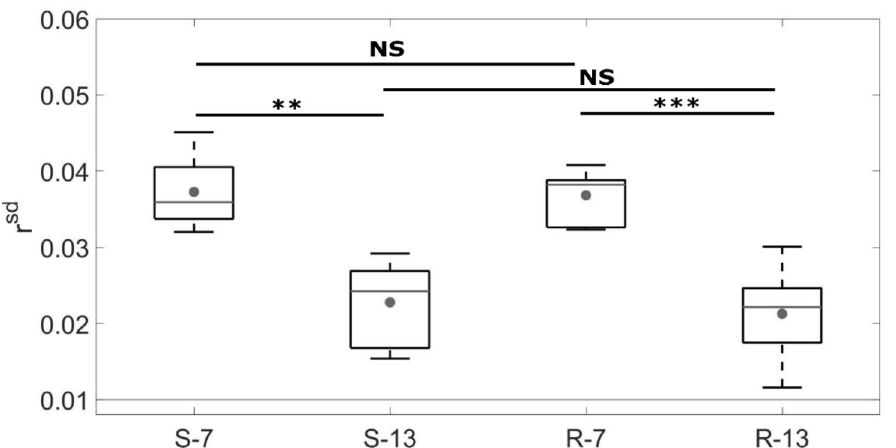
Figure 6. Standard deviation r sd of the ratio r for the samples belonging to each group, which corresponds to the heterogeneity of the distribution of r . The dots represent the mean value, the grey lines the median value, the bottom (respectively top) edges of the box the 25th (respectively 75th) percentiles and the whiskers extend to the most extreme data points. The light grey line at 0.01 corresponds to the value for the intact implants. The Mann– Whitney U-tests lead to: ** p value < 0.01; *** p value < 0.001; NS (non-significant difference) p value >